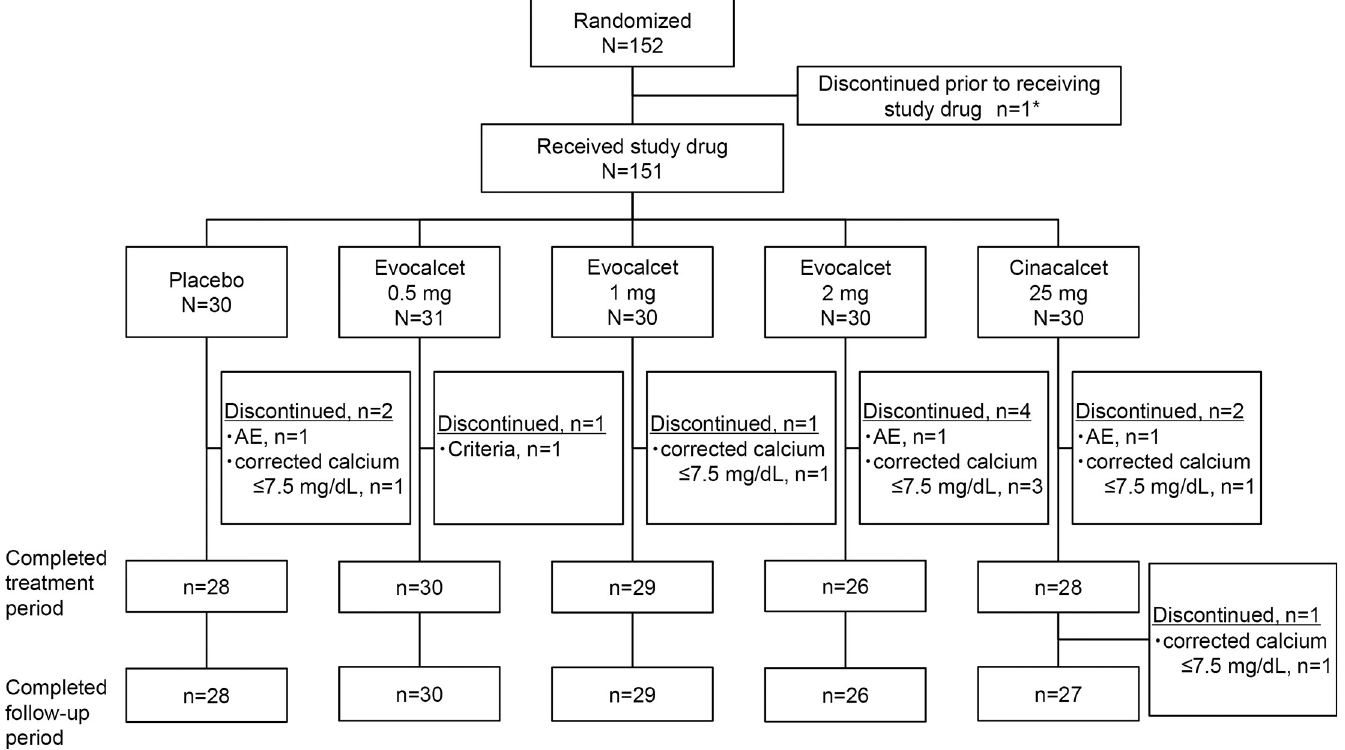
Fig 1. Patient disposition. � Tumor was identified by cervical ultrasonogram. AE, adverse event.